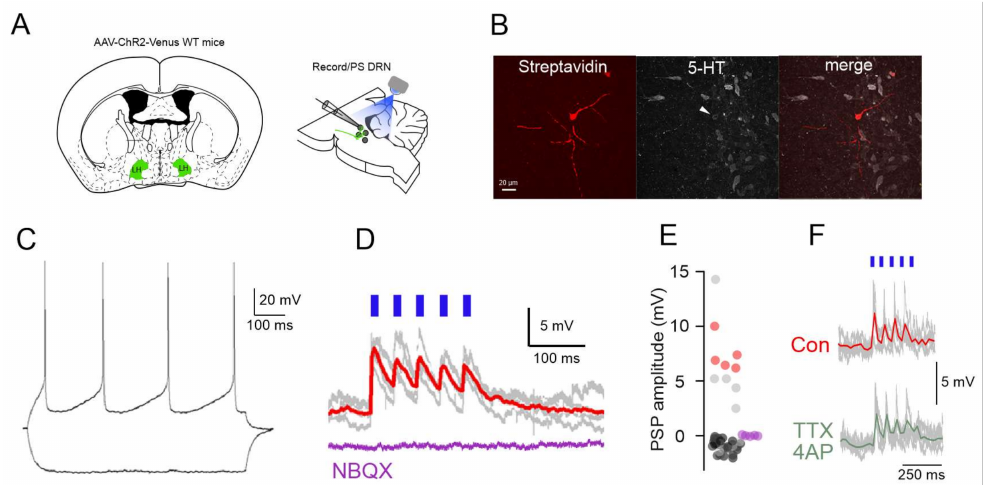
Figure 2. Functional excitatory projections from LH to DRN. ( A ) Schematics of the experimental design for the in vitro circuit mapping experiments. ( B ) Fluorescent images (Streptavidin, 5-HT im- munostaining, merged) of a DRN 5-HT neuron responding to LH axonal photostimulation. ( C ) Mem- brane potential responses of the neuron in ( B ) to hyperpolarizing and depolarizing current steps. ( D ) The photostimulation of LH axons leads to EPSPs in the neuron shown in ( B , C ) (gray traces: individual voltage responses, red trace: average) that are blocked by the iGluR antagonist (NBQX, purple trace). ( E ) Distribution of PSP amplitudes in all the recorded neurons (n = 51) (red circles indi- cate identified DR-5-HT neurons, gray circles unidentified neurons, purple circles EPSP amplitudes following NBQX application (n = 5). ( F ) Persistence of the LH axonal photostimulation induced EPSPs in TTX/4AP in a DRN